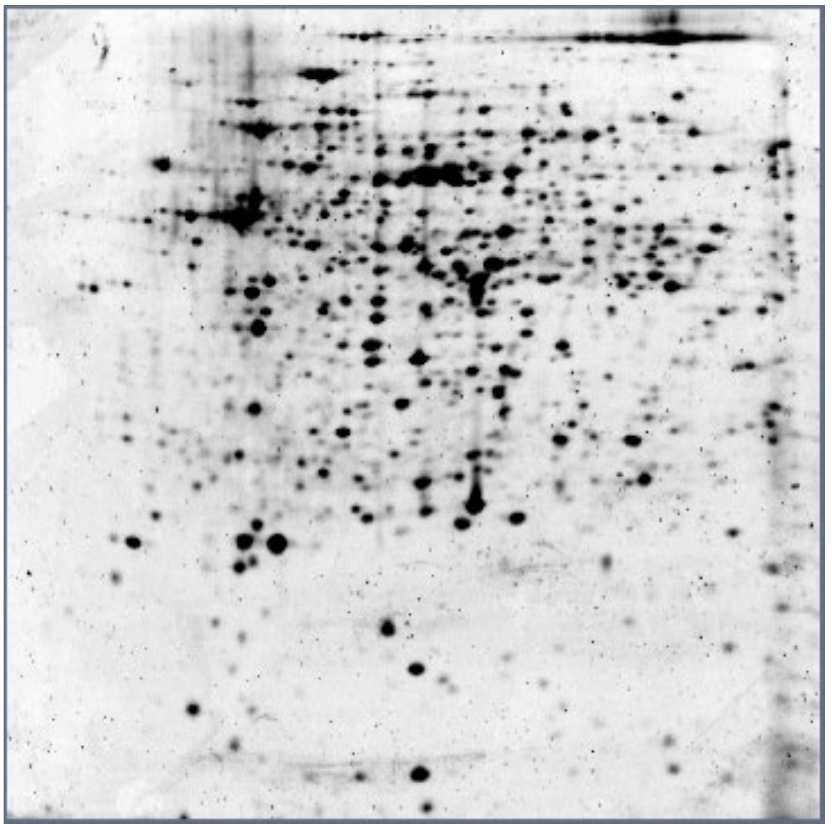
Figure 1. An electropherogram of Geobacillus icigianus G1w1 proteins. The strips (first direction) were 17 cm long (pH of 4–7); the SDS 12% polyacrylamide gel (second direction) was subjected to Sypro Ruby staining. Ruby